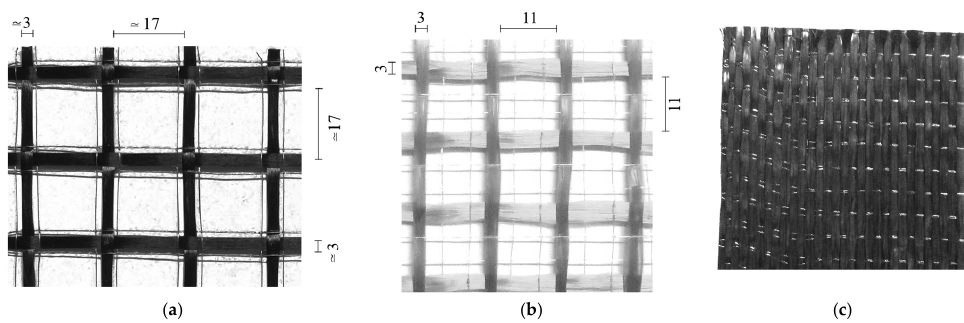
Figure 1. ( a ) Poliparafenilenbenzobisoxazole (PBO) balanced textile; ( b ) basalt balanced textile; ( c ) unidirectional carbon sheet. Dimensions in mm. Table 2. Properties of the composite materials provided by the manufacturer. t f = equivalent